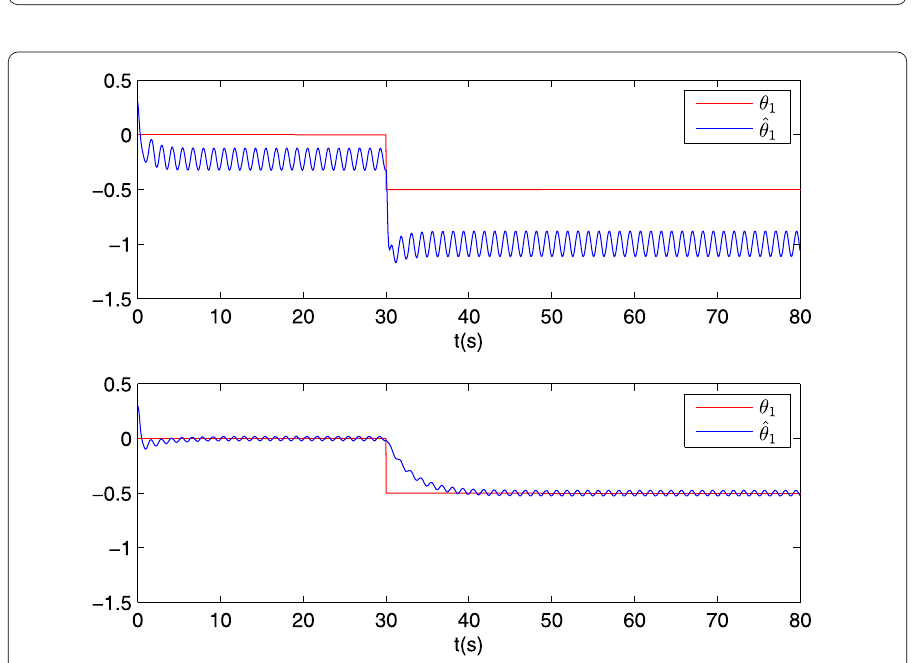
Figure 3 Actuator fault parameter θ 1 ( t ) and its estimation. The red line denotes state θ 1 ( t ) while the blue line denotes its estimation. The lower part is the result obtained using method proposed in this paper, while the upper part is the result obtained using method proposed in